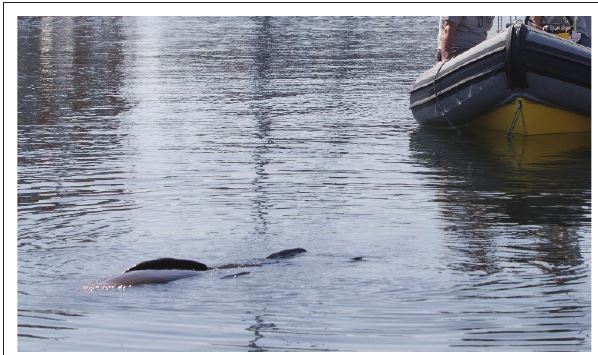
FIGURE 1: A sedated fur seal ready to be retrieved by